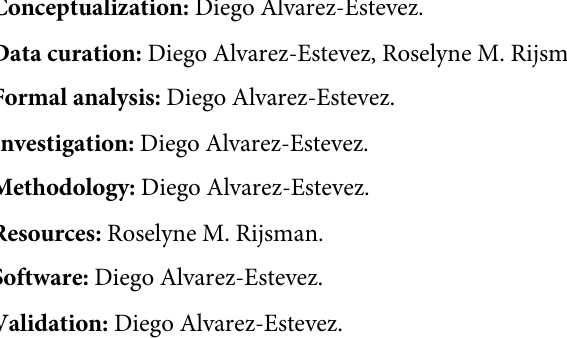
S1 Table. Summary characteristics of the datasets included in the